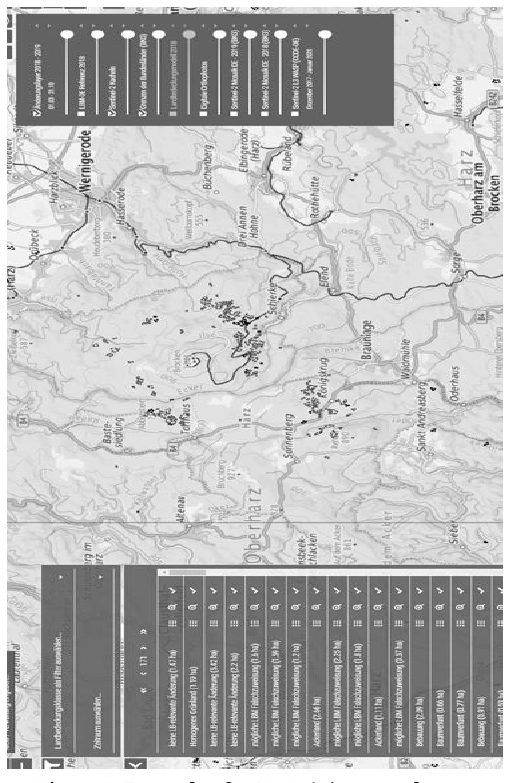
Figure 5 . Example of LaVerDi change